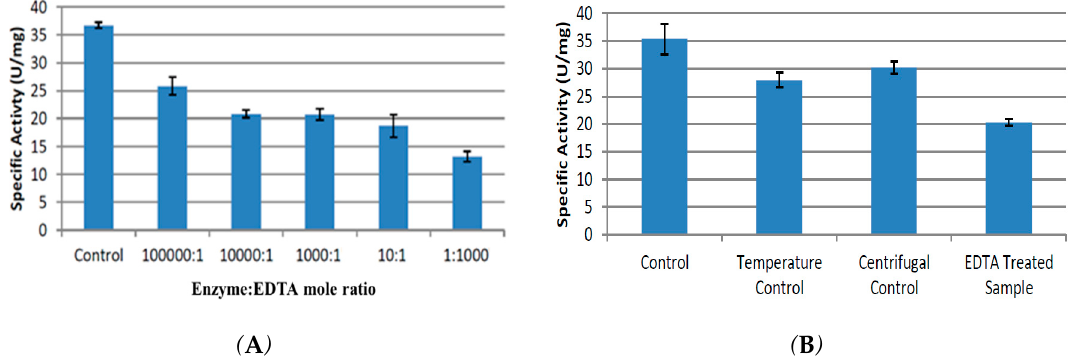
Figure 2. Activity of CpCR after chelation with EDTA ( A ) Effect of EDTA on CpCR activity at various concentrations; ( B ) Change in specific activity of CpCR before and after incubation at 4 ° C.